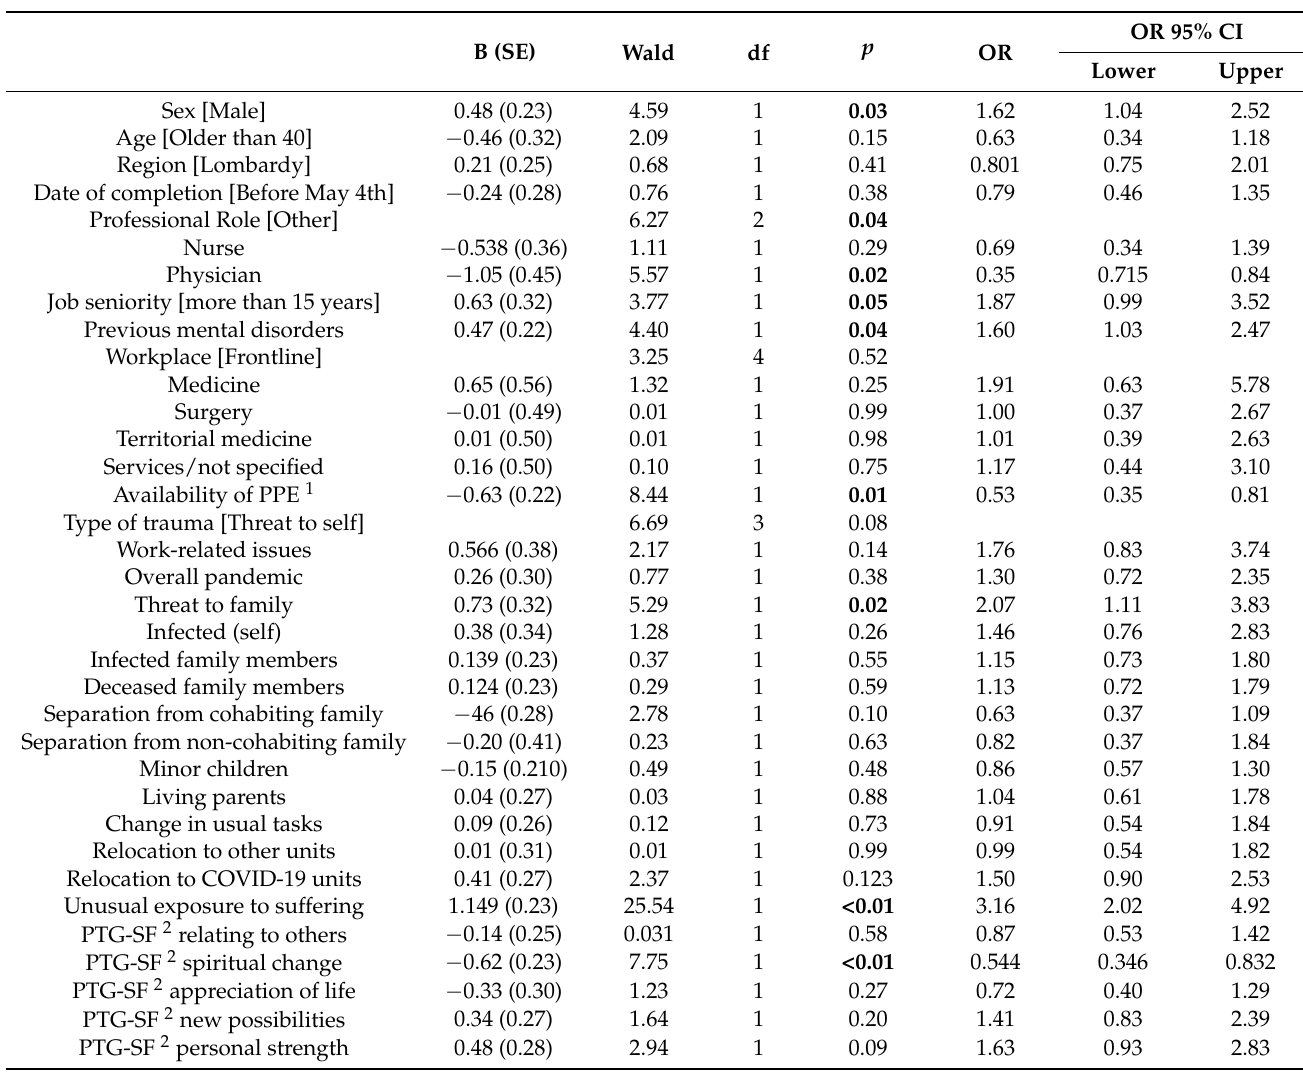
Table 1. Binary logistic regression analysis with provisional PTSD diagnosis as dependent